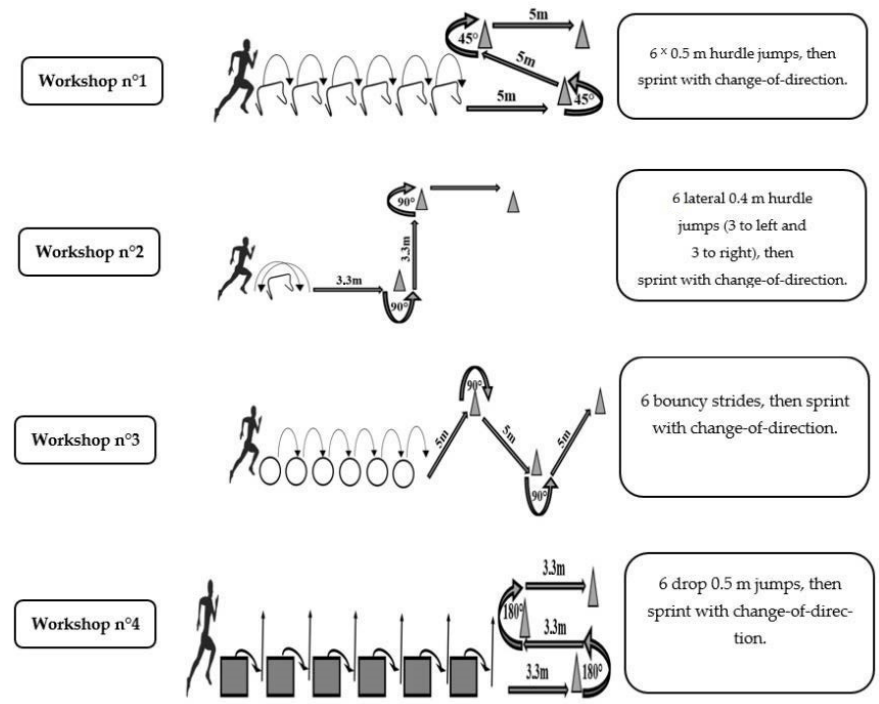
Figure 1. Exercise used in loaded combined plyometric and short sprint with change-of-direction training jump.